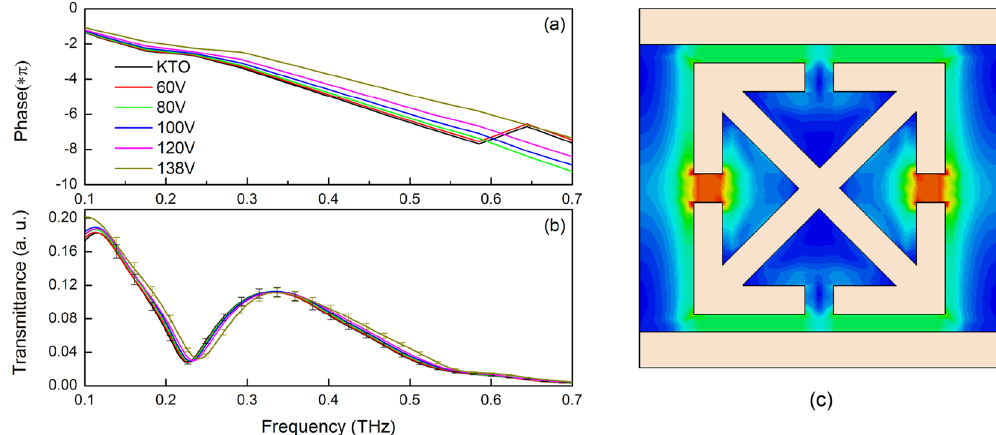
Figure 3. ( a ) Phase change and ( b ) transmission spectrum of KTO hybrid metamaterial sample under external voltages at room temperature. ( c ) Simulated electric field distribution of the LC resonator structure at resonance